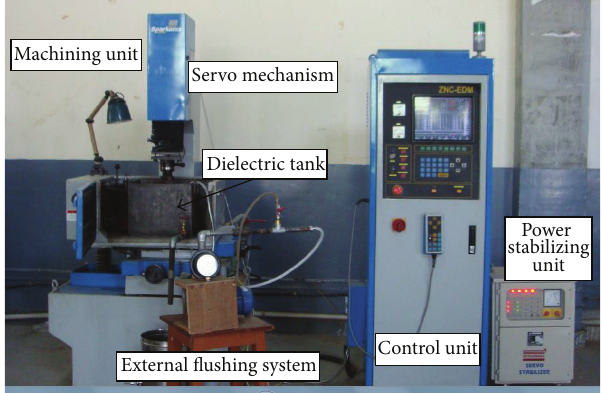
Figure 7: ZNC EDM setup for experiment.